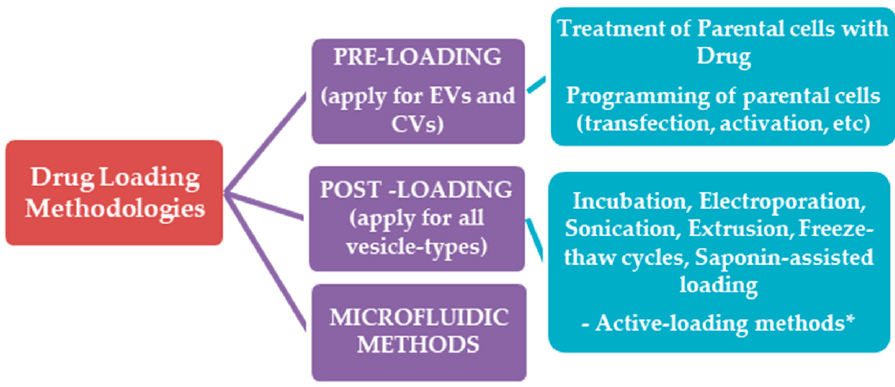
Scheme 4. Categories of methods used for loading drugs into EXs and EX-like